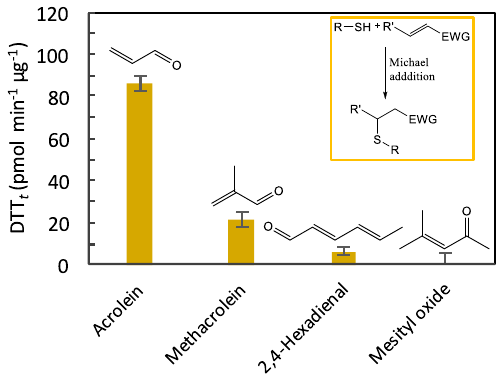
Figure 6. The DTT t ( t = 30min) of four different electron-deficient alkenes. Each error bar was calculated by t 0 . 95 × σ/ replicates, where t 0 . 95 is the t score (4.303 for n = 3 replicates) with a two-tail 95% confidence level. EWG in the mechanism represents an electron-withdrawing group (Nair et al.,